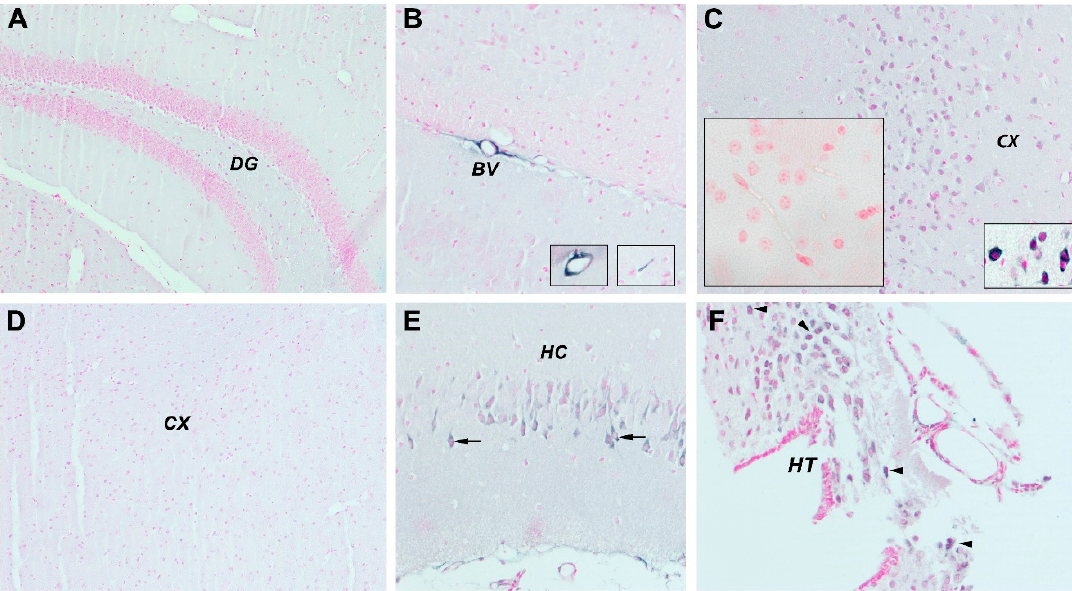
Figure 4. In our stereotactically mCRP-injected murine model, we observed the pattern of mCRP distribution after 4 weeks. We found no evidence of mCRP staining in control mice ( A , D ), and a strong hippocampal staining of neurons in mCRP injected mice ( E ) adjacent to the injection site. ( C ) Many medium and small cortical vessels became positively stained for mCRP ( B ), and hypothalamic neurons became positively stained in the cytoplasm of mCRP-treated mice ( F ). The inset in ( C ) shows the isotype IgG control. Abbreviations: DG indicates dentate gyrus of the hippocampal formation, BV, blood vessels; CX, cerebral cortex; HC, hippocampus; HT, hypothalamus.